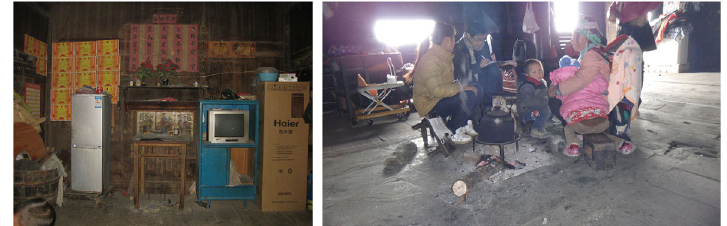
Fig. 4 Ancestral altar (left) and traditional hearth (right) in Shui houses (Source: the